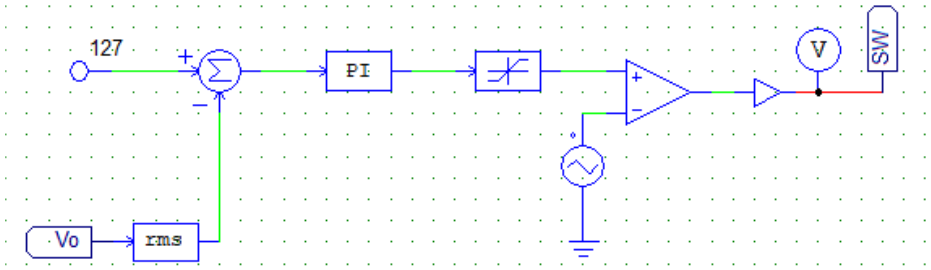
Figure 26. Controller diagram.